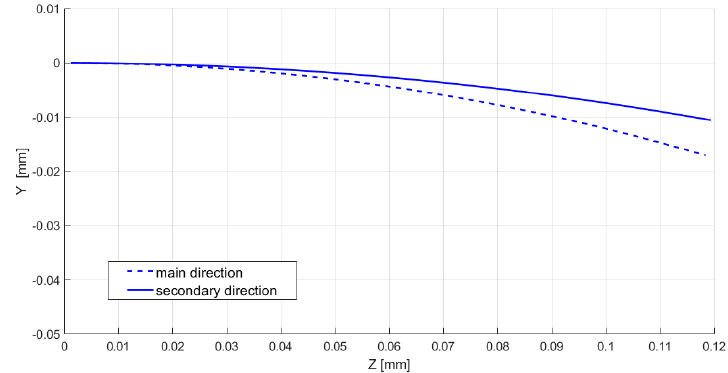
Figure 7. Axis of central rod of the actuator in equilibrium condition.